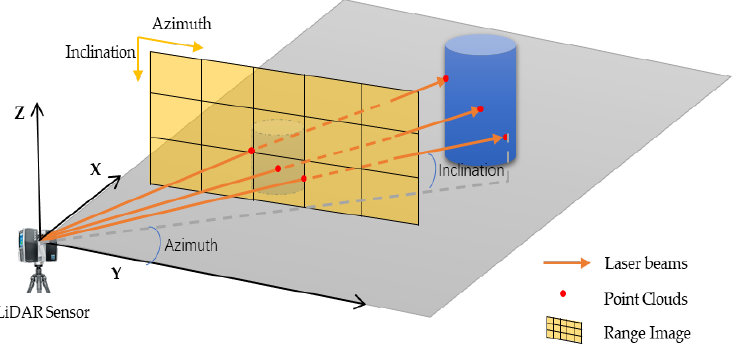
Figure 4. Reflective intensity value range image extract view.